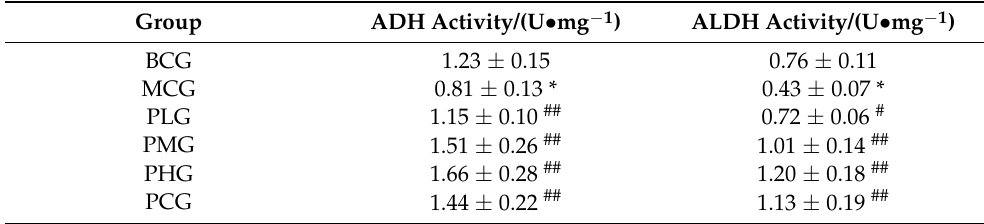
Table 2. Effect of P. perfoliatum on key enzymes of ethanol metabolism induced by alcohol in mice (n = 10, X ± s).